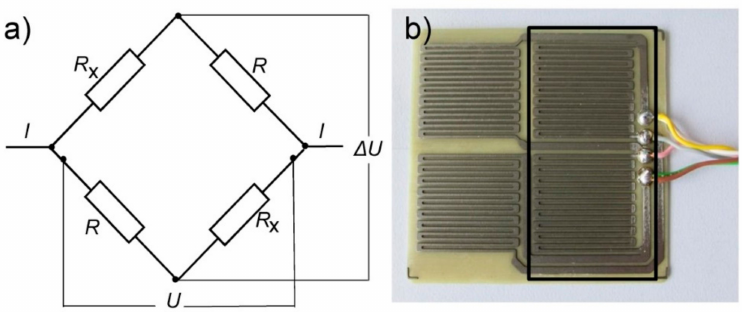
Figure 2. ( a ) Schematic presentation of the corrosion electrical resistance sensor and ( b ) a photo of the sensor, protected with an epoxy coating (rectangle) on the 2 sensor elements with the